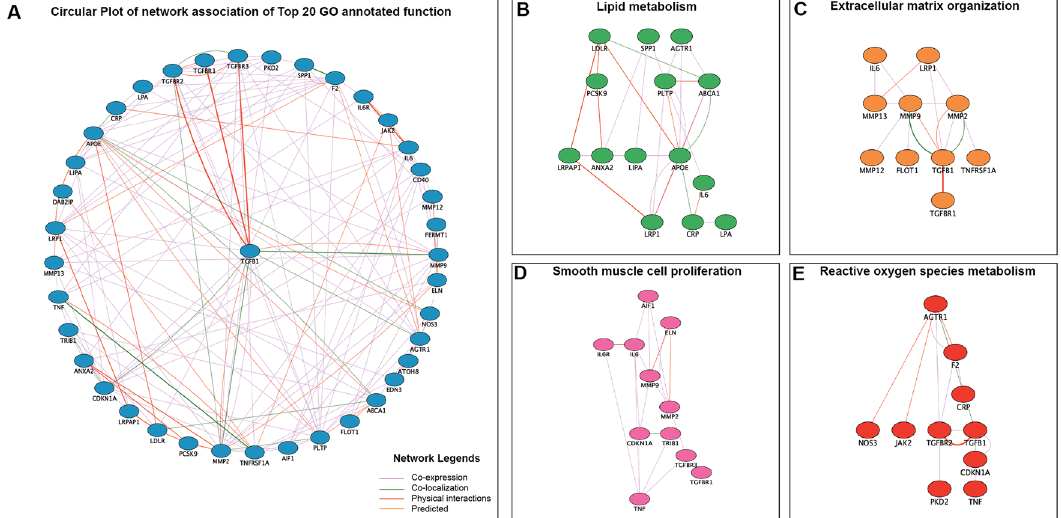
Figure 5. GeneMANIA interaction network from the SNPs associated genes in AAA. ( A ) Circular plot of network association according to top 20 gene ontology annotated function. Transforming growth factor-beta (TGFB1) shares strong physical interaction with its receptor; transforming growth factor beta receptor 1, 2, and 3 ( TGFBR1 , TGFBR2 , TGFBR3 ) as well as a strong co-localization with matrix metalloproteinase 9 ( MMP9 ). The network of hub genes associated with AAA-related pathways consists of ( B ) lipid metabolism pathway, ( C ) extracellular matrix (ECM) organization, ( D ) smooth muscle cell proliferation, and ( E ) reactive oxygen species (ROS) metabolism is hierarchically plotted to show their interaction. The color depth of nodes represents the corrected